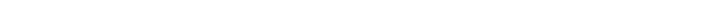
Algorithm 1 Dataset creation